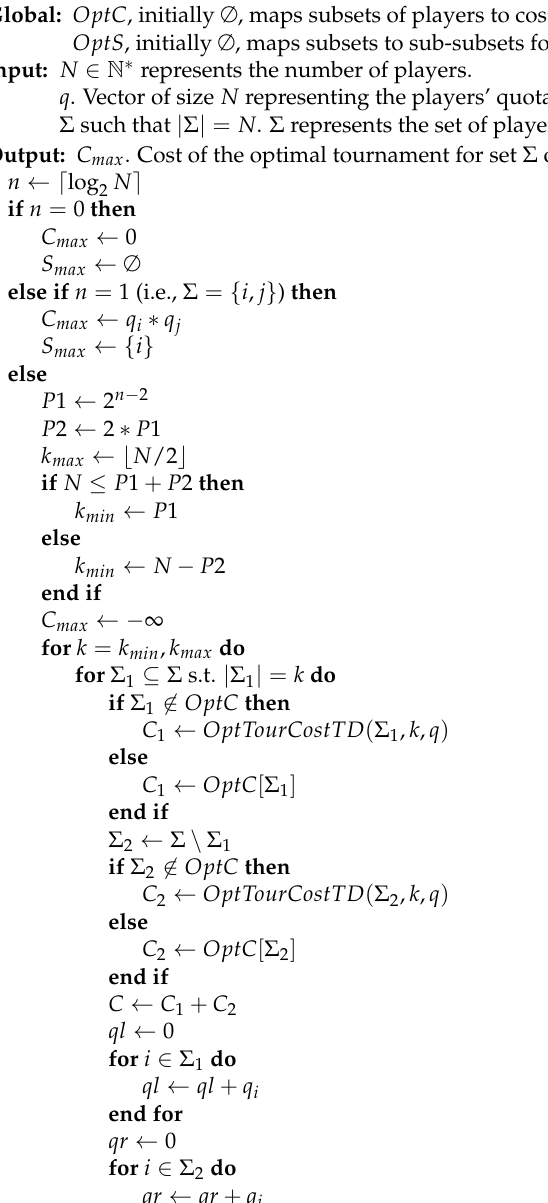
Algorithm 1 OptTourCostTD ( Σ , N , q ) top-down dynamic programming algorithm with memoization for computing the cost of the optimal